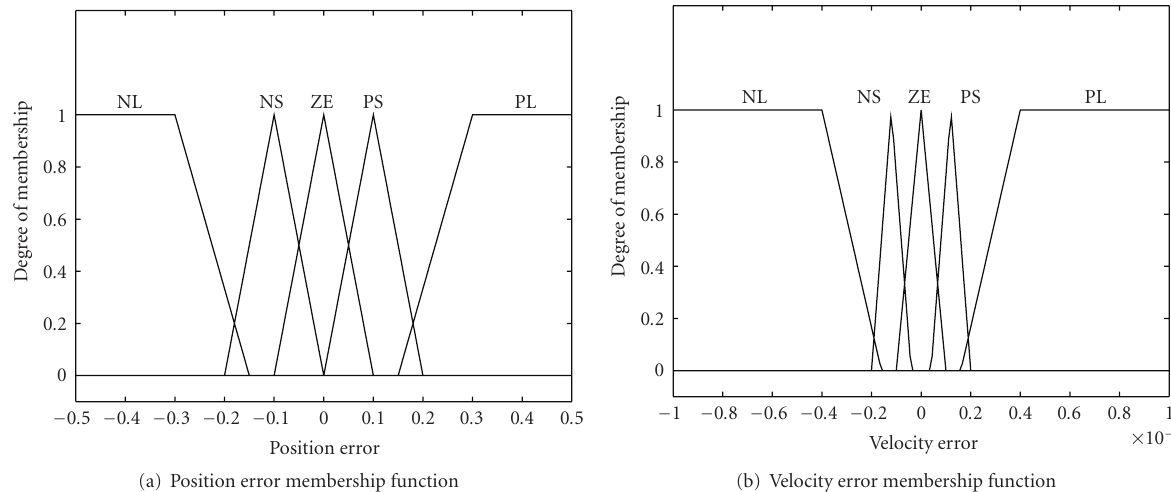
Figure 3: Membership functions of fuzzy inputs.